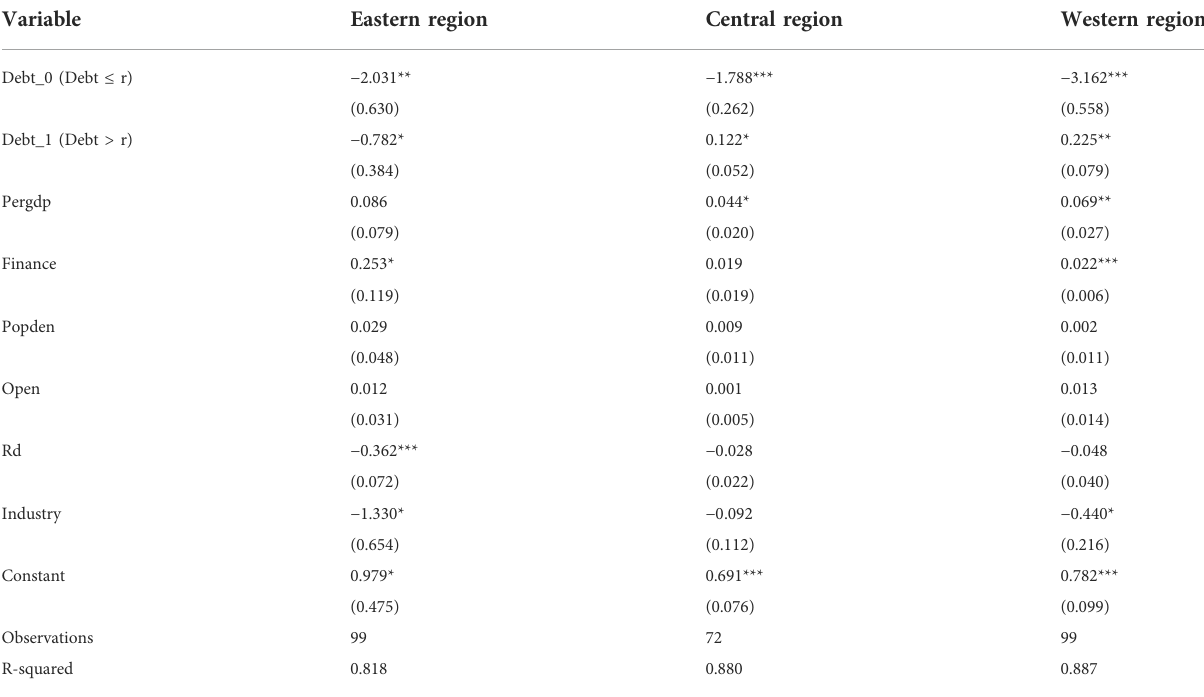
TABLE 10 The estimation results for regional heterogeneity.